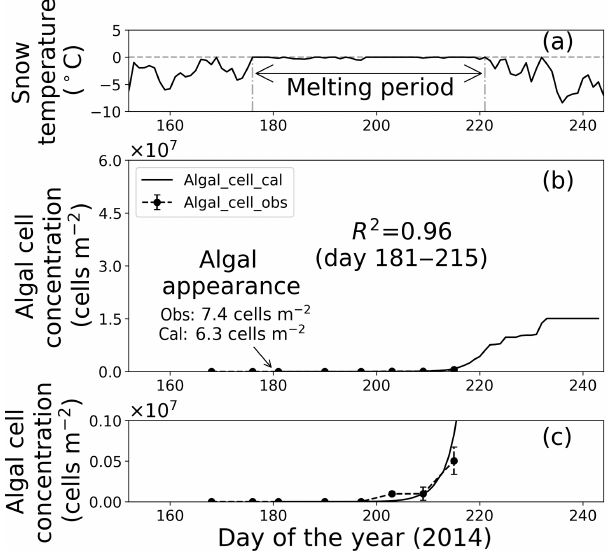
Figure 8. Temporal changes in snow temperature and algal abun- dance on surface snow at Site B. (a) Mean daily snow surface tem- perature, (b) observed and calculated algal abundance, and (c) en- largement of the observed and calculated algal abundance between 0 and 1.0 × 10 6 cellsm − 2 . Surface snow temperature was calculated from observed downward and upward long-wave radiant fluxes. Solid marks indicate observed algal abundance. Solid lines indicate algal abundance calculated from regression by the logistic model. Standard deviation shown by error